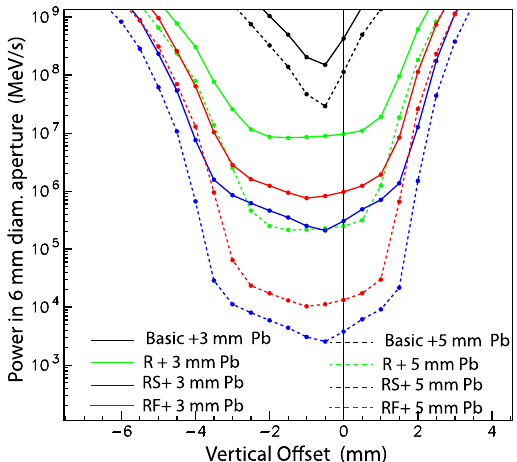
FIG. 8. The effect of possible electron-beam misalignment is shown by plotting power of the synchrotron radiation entering a 6-mm-diameter collimator as a function of vertical beam position. A 100 μ A beam is